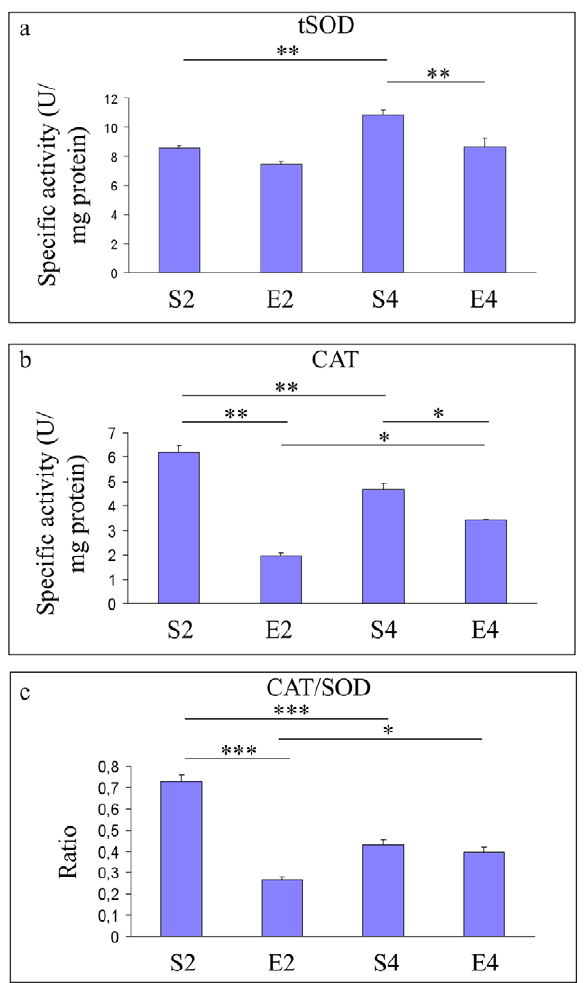
Figure 3. Antioxidant enzymatic defense in hippocampi of mice undergoing 2- or 4-mo moderate treadmill running. Evaluation of hippocampal specific activities of the major antioxidant enzymes total superoxide dismutase (tSOD) and catalase (CAT) in mature CD-1 female mice undergoing a two- or four-month moderate and regular treadmill-based exercise program (E2 or E4, respectively); age-matched sedentary animals (S2, S4) were used as controls (n=12 per group). Sedentary aging increased the tSOD activity (S4 vs S2, panel a), but decreased both the CAT activity (S4 vs S2, panel b) (panel b) and the CAT/tSOD ratio (S4 vs S2) (panel c). 2-mo running reduced the CAT specific activity (E2 vs S2) and the CAT/tSOD ratio (E2 vs S2) (panels b and c, respectively), while 2-mo exercise did not change the tSOD activity (E2 vs S2) (panel a). 4-mo running decreased specific activities of both tSOD and CAT (E4 vs S4) (panels a and b, respectively), without changing the CAT/tSOD ratio (panel c). Values were given as means 6 std. dev. The level of statistical significance was computed by using